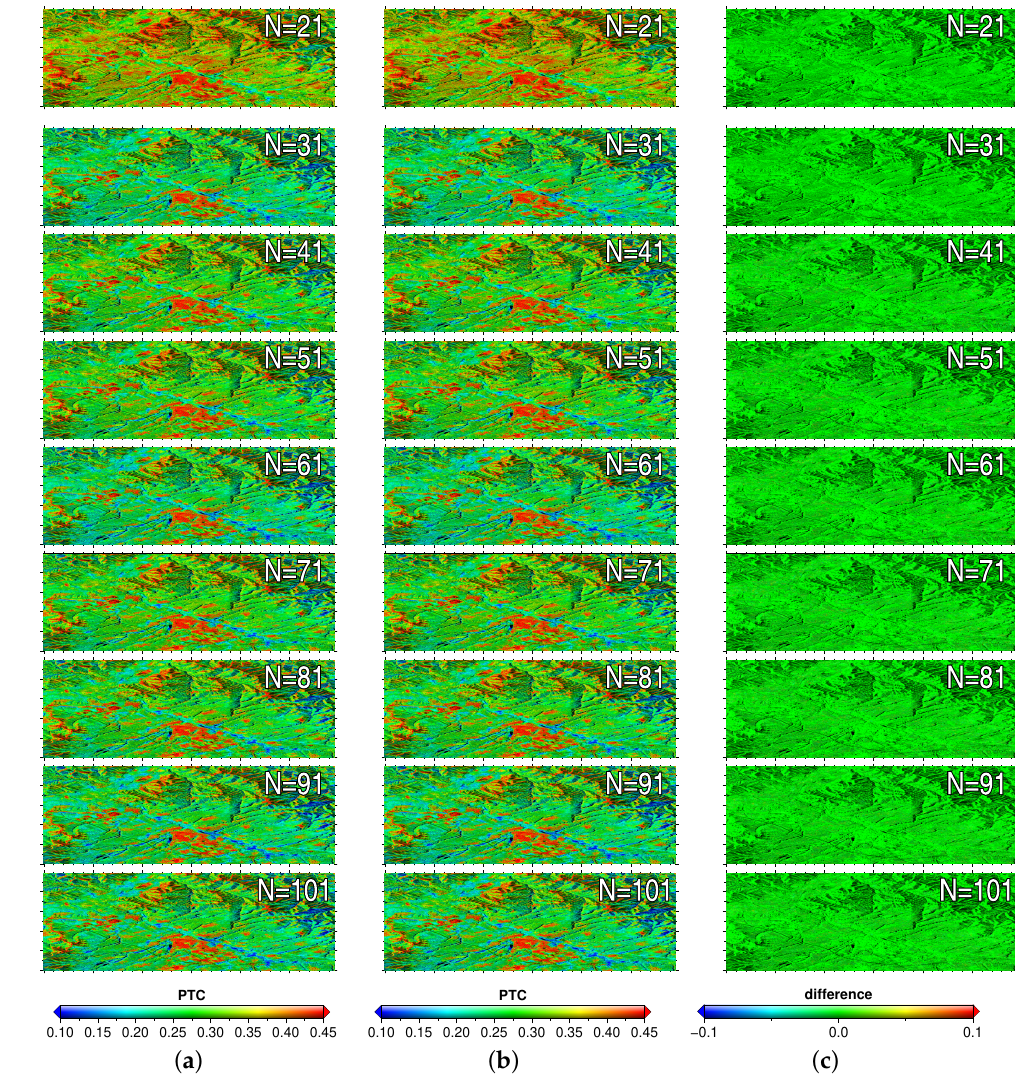
Figure 5. The PGoF maps from the EVD method ( a ) and the CPPCA method ( b ) under different SAR stack dimensions. The corresponding difference maps are listed in ( c